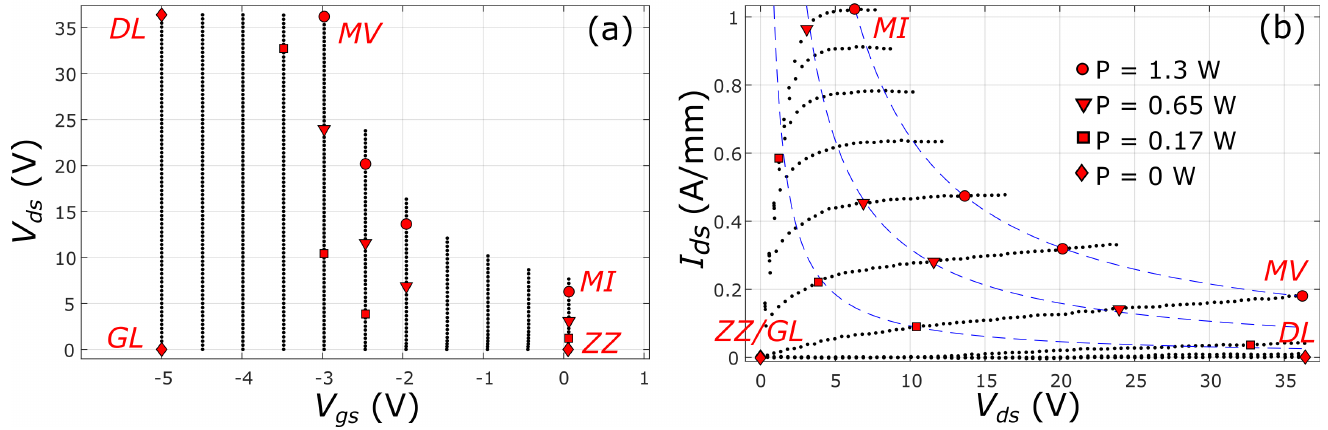
Figure 5. Selection of a meaningful subset of quiescent points from the static-IV characteristic of the device. The three key quiescent points for gate/drain-lag characterization GL , DL , and ZZ are at zero dissipated power. The other selected quiescent points are found on three iso-thermal IV-characteristics at dissipated powers 1.3 W, 0.65 W, and 0.17 W. ( a ) V GS − V DS plane. ( b ) Static-IV characteristic for device A at T C = 40 ◦